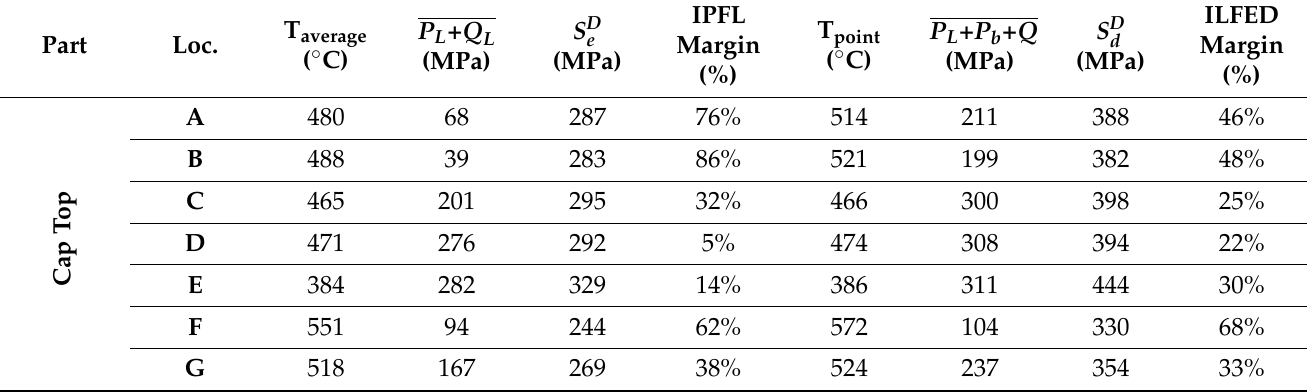
Table 1. Assessment against IPFL and ILFED damage modes according to elastic criteria.